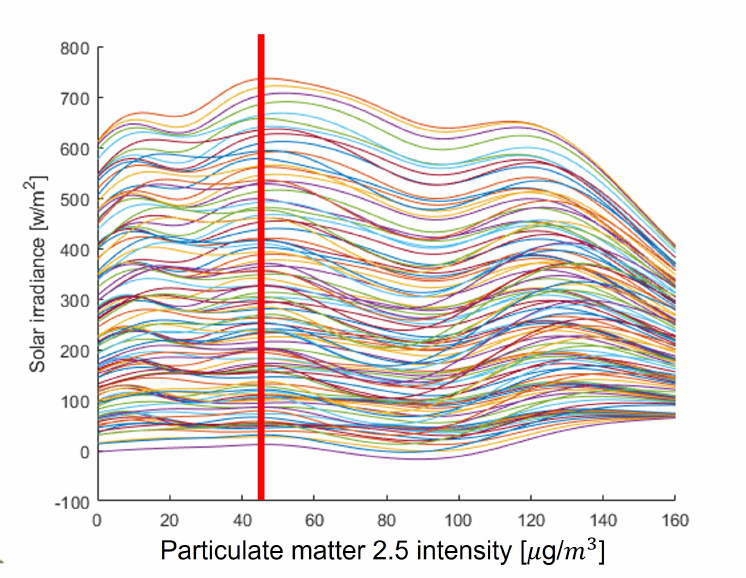
Figure 6. Neural network analysis on the influence of particulate matter to the level of solar irradiation measured on the